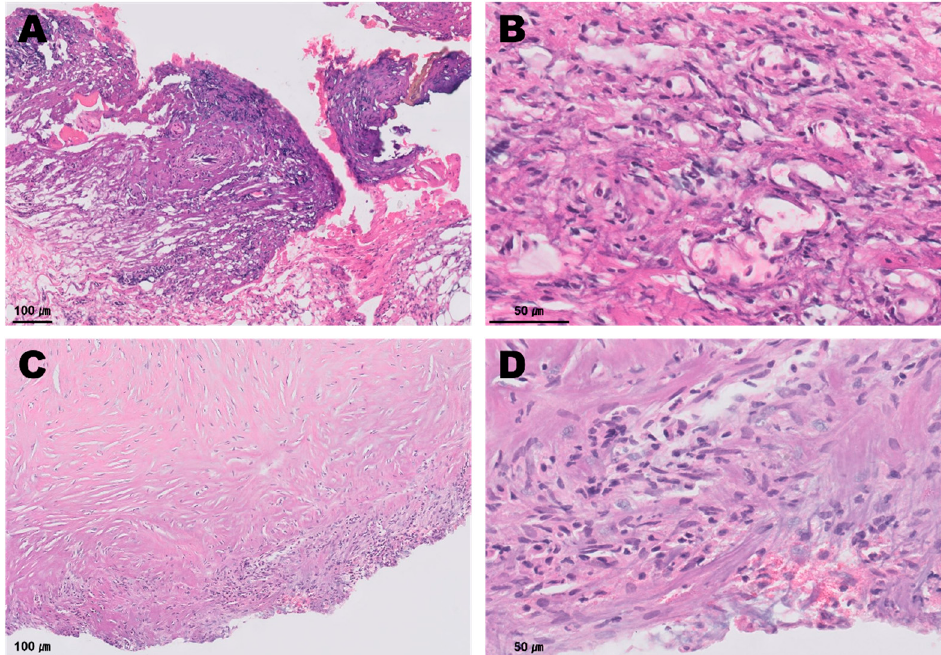
Figure 4. Histopathology of the periaortic mass ( A , B ) and the pericardium ( C , D ). The periaortic mass contained abundant basophilic fibrillary cell debris intermixed with bands of fibrin, reactive fibrovascular stroma containing scattered mononuclear inflammatory cells. A small amount of adipose tissue was intermixed with fibrin and loosely scattered neutrophils, macrophages, lymphocytes and plasma cells. The thickened pericardium contained loosely scattered fibrocytes, and fewer fibroblasts were observed. A small amount of basophilic fibrillar cell debris, a small number of scattered neutrophils and fewer macrophages embedded in collagen were identified.